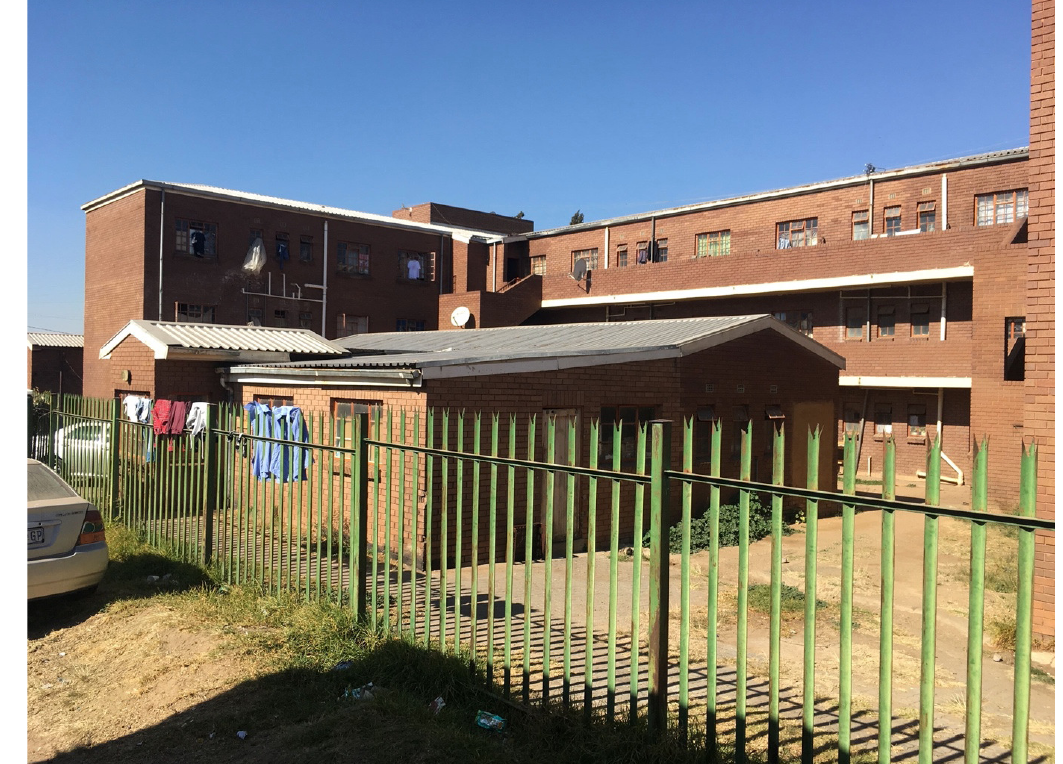
Figure 1. A view of the Denver Men’s Hostel. Source: Photo by the author, 2019.